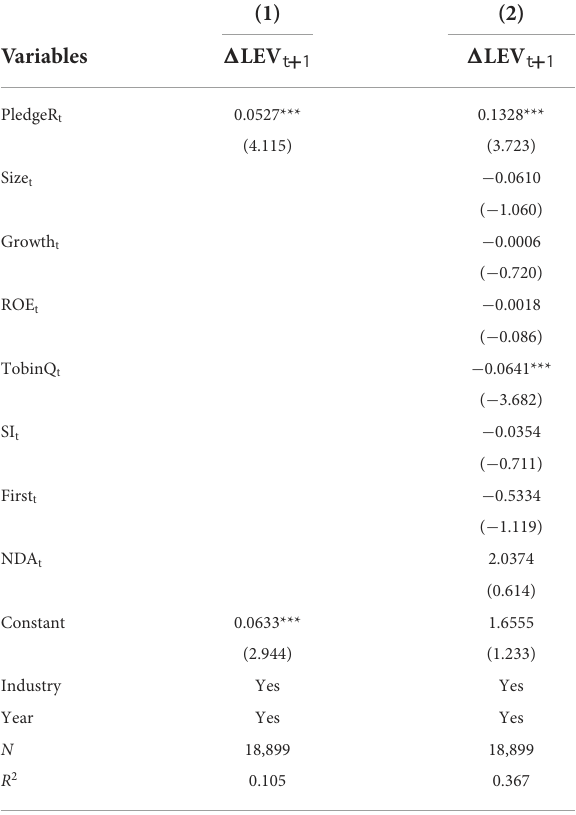
TABLE 4 The association between share pledge of ultimate owner and firm’s debt maturity